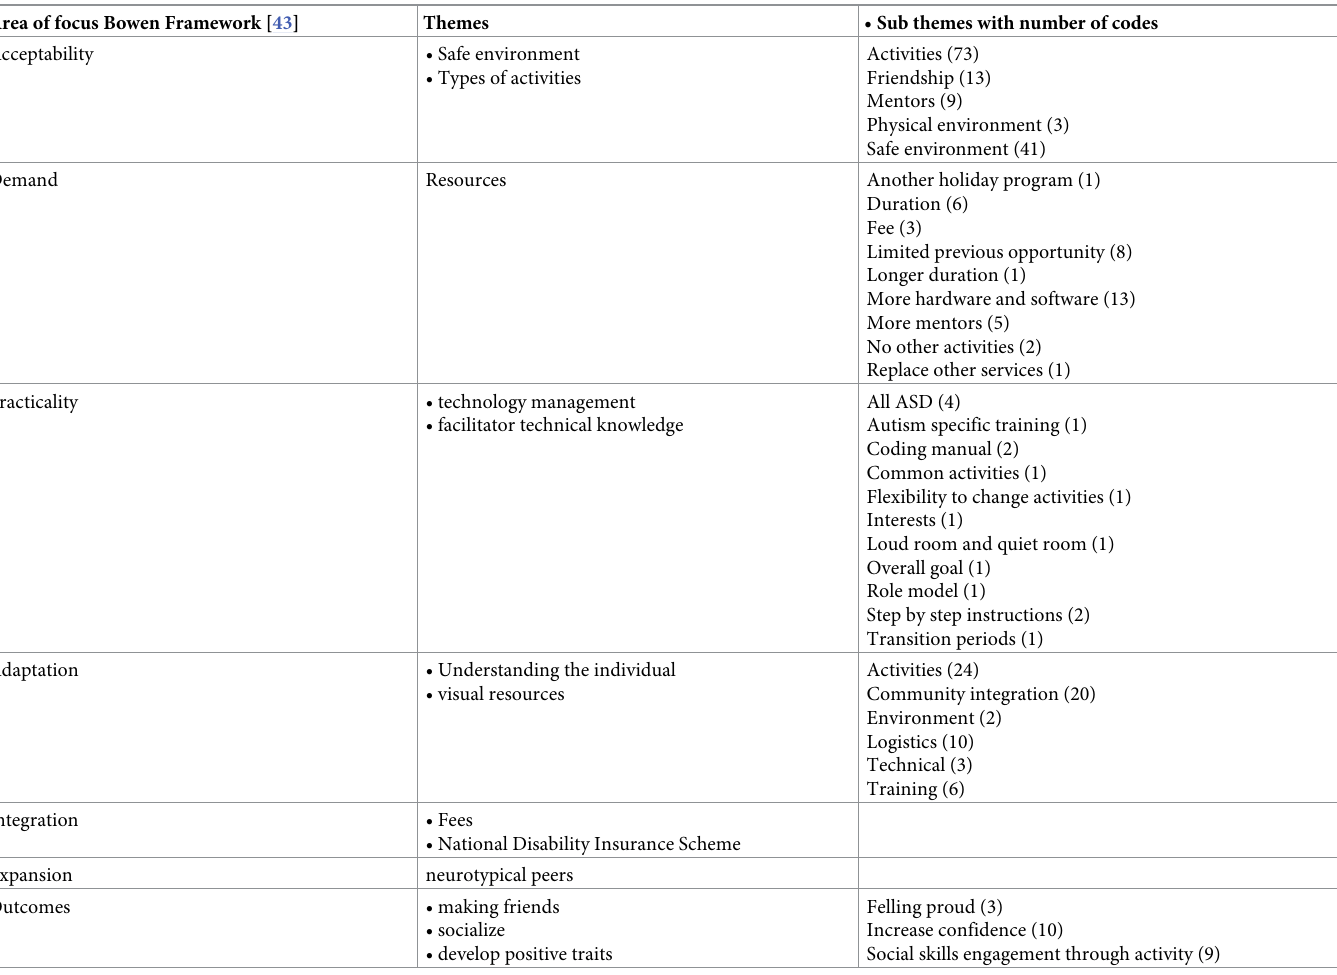
Table 5. Thematic map of qualitative